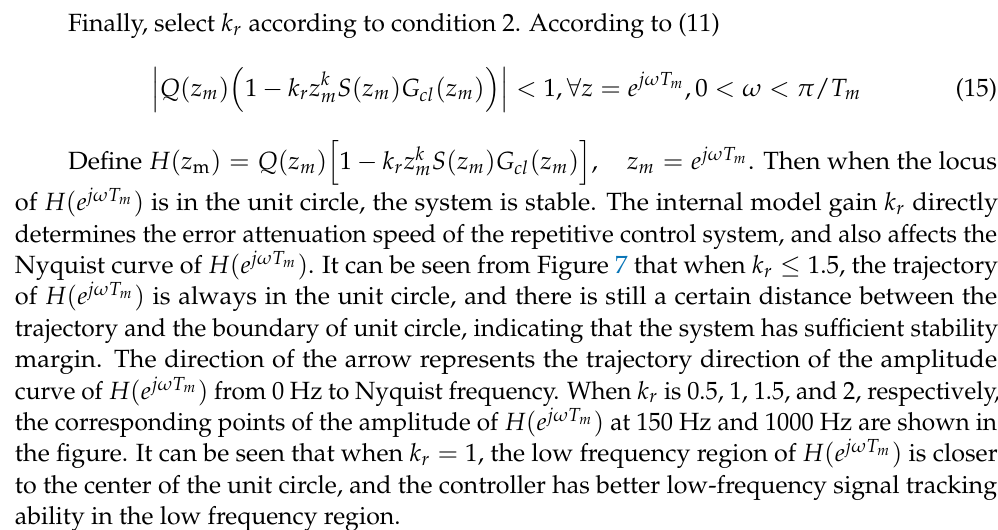
Figure 6. The amplitude-frequency and phase-frequency characteristics of S ( z m ) G cl ( z m ) when k takes different